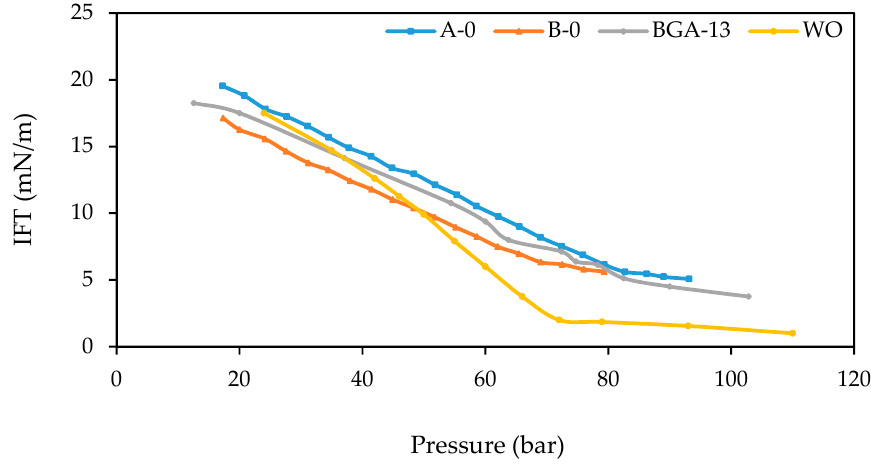
Figure 7. Interfacial tension (IFT) tension for CO 2 -crude oils (WO = Weyburn crude oil-CO 2 system against equilibrium pressure data at T = 27 °C [78]; A-0 and B-0 = Iranian crude oils at 49.85 °C [79]; BGA-13 = Iranian crude oil at 48.85 °C [80].